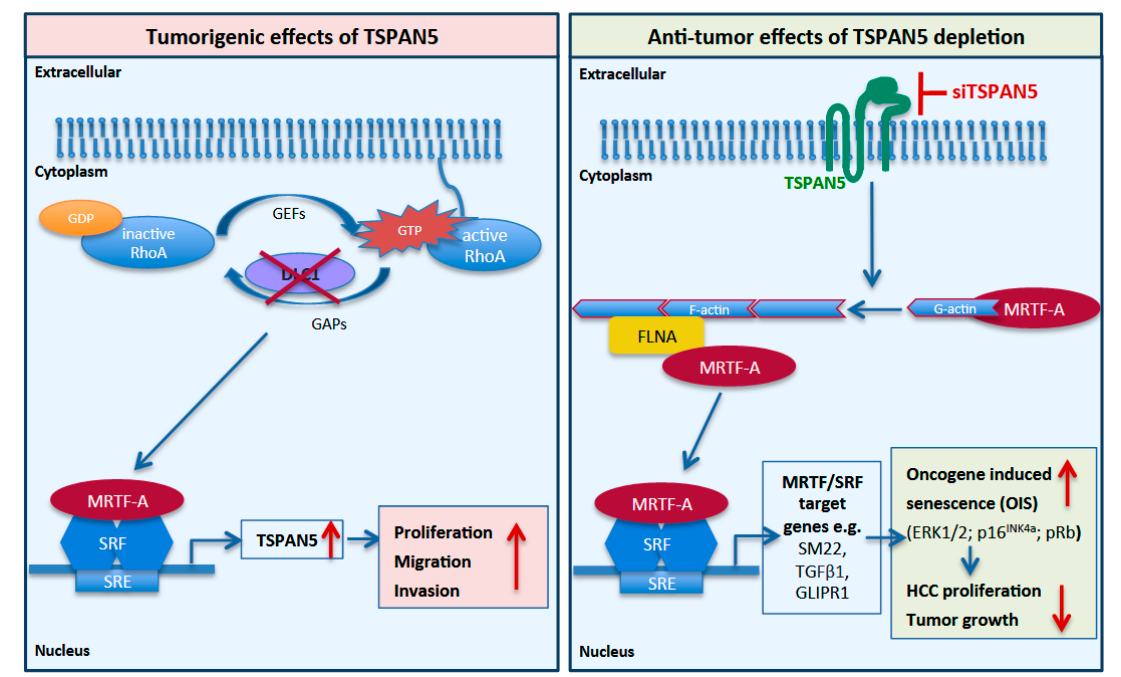
Figure 8. Model for the tumorigenic effects of TSPAN5 and the anti-tumorigenic effects of TSPAN5 depletion. DLC1 loss leads to increased TSPAN5 expression via MRTF-A transcriptional activation (left panel). Therapeutic knockdown of TSPAN5 results in OIS-induced inhibition of HCC growth via decreased actin polymerization and reduced MRTF/SRF target gene expression (right panel).